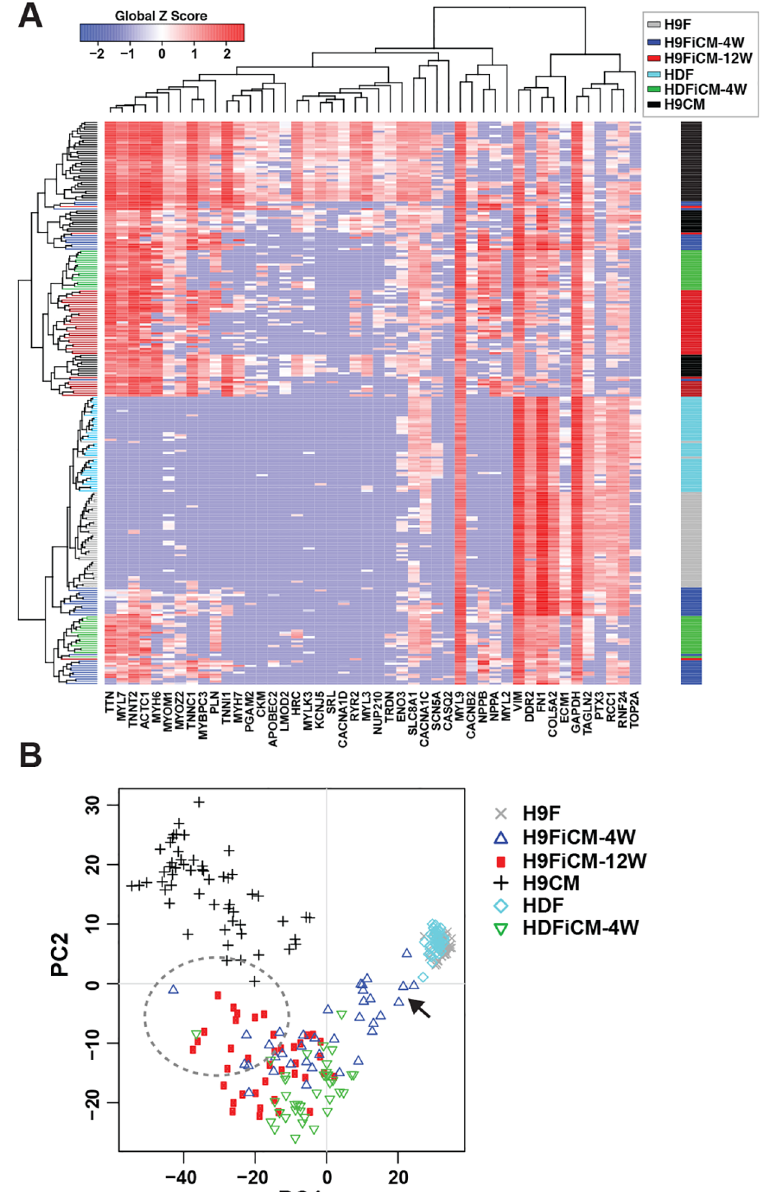
Fig 3. The expression profile of the identified 46 genes is able to estimatethe quality of human iCM reprogramming. A) A hierarchical clustering analysisshowedthat most human iCMs reprogrammedfrom H9Fs by 7 factors of GMTEMMZ for 12 weeks (H9FiCM-12W, n = 39) were clusteredclose to H9CMs, while many iCMs reprogrammed from H9Fs (H9FiCM-4W, n = 36) and HDFs (HDFiCM-4W, n = 37) for 4 weeks were clustered close to fibroblasts. B) Principalcomponent(PC) projections of individual cells. The dash-line circle surroundsa population of iCMs that had a goodquality of reprogramming; the arrow indicatesanother population of iCMs that were poorly